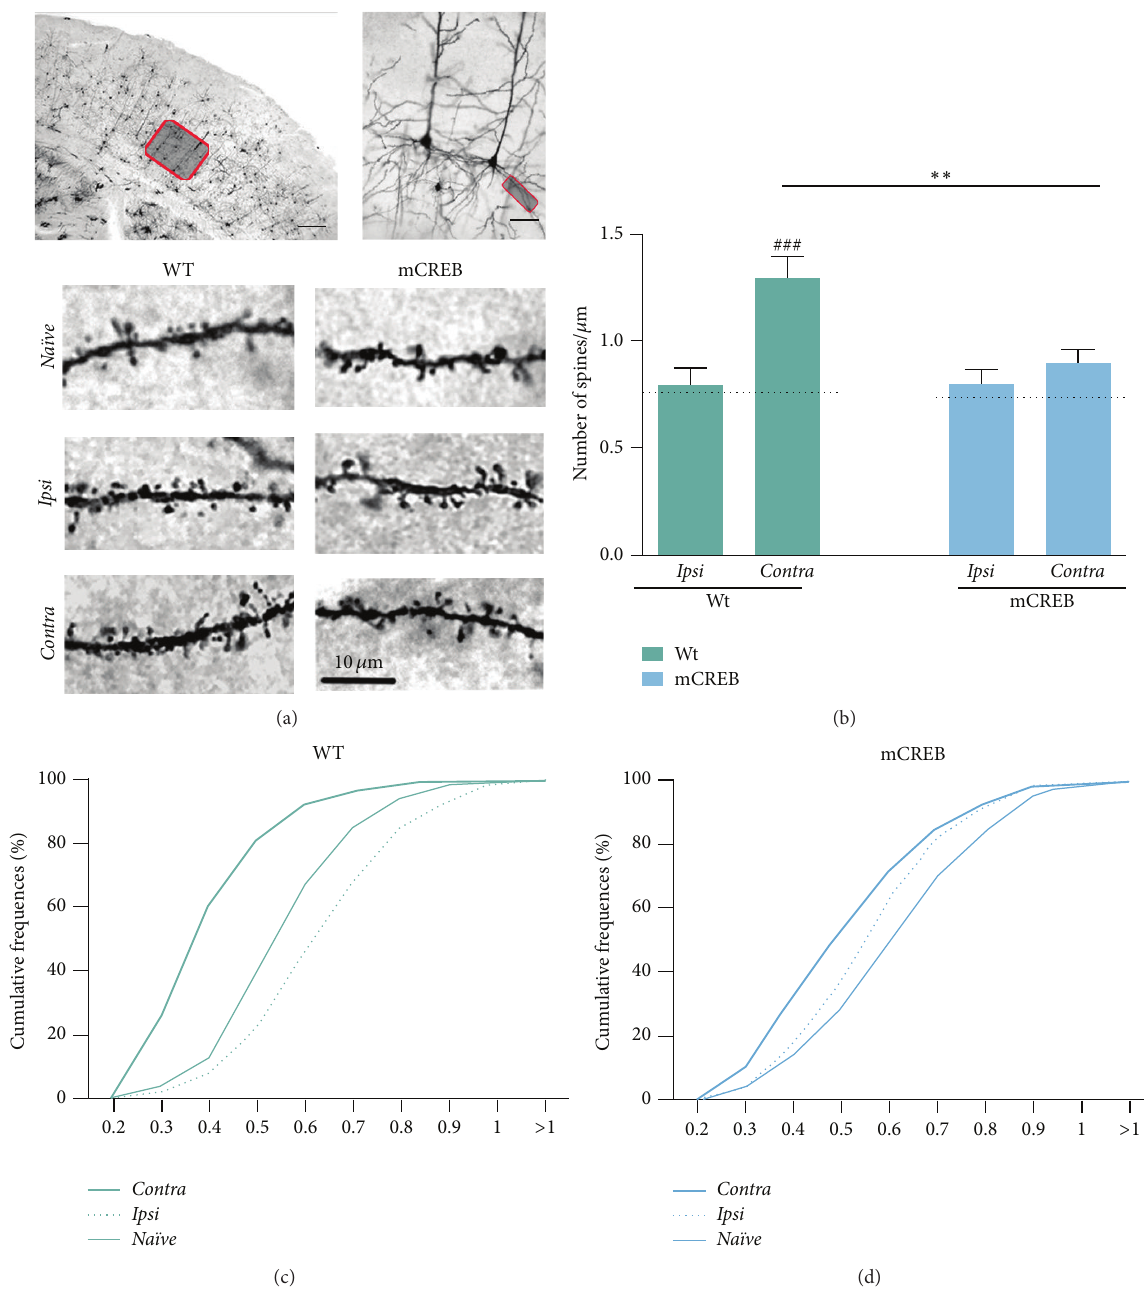
Figure 3: CREB is necessary for dendritic spine reorganization associated with whisker trimming. (a) Photomicrographs of Golgi-stained barrel cortex area (top-left, red square refers to layer V barrel cortex area; scale bar 250 𝜇 m), representative barrel cortex neurons (top-right, red square refers to basal dendrites along layer V neurons; scale bar 50 𝜇 m), and segments of basal dendrites (bottom, scale bar 10 𝜇 m) from wild type (WT) and mCREB mice in Na¨ıve and trimmed condition ( Na¨ıve , Ipsi , and Contra ). (b) Histograms depicting dendritic spine density measured on basal dendrites of layer V pyramidal neurons in wild type (WT) and mCREB trimmed mice. Values are expressed as number of spines (mean ± s.e.m.) per 1 𝜇 m segment. Dotted line indicates average spine density in relative Na¨ıve groups. ### < 0.001 (difference from relative Na¨ıve controls); ∗∗ < 0.01 (difference between genotypes). ((c)-(d)) Cumulative frequencies relative to head diameter widths measured on dendritic spines of Wt (c) and mCREB mice (d). 𝑁 = 6 mice for each genotype, 7/8 neurons for each mouse, about 600 spines for each experimental